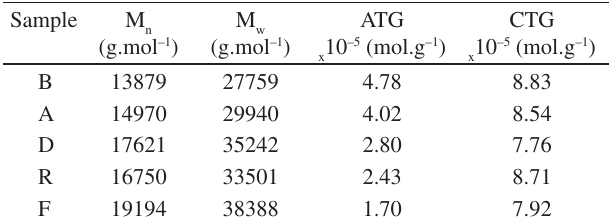
surface tension, τ , and electrical conductivity, 0,